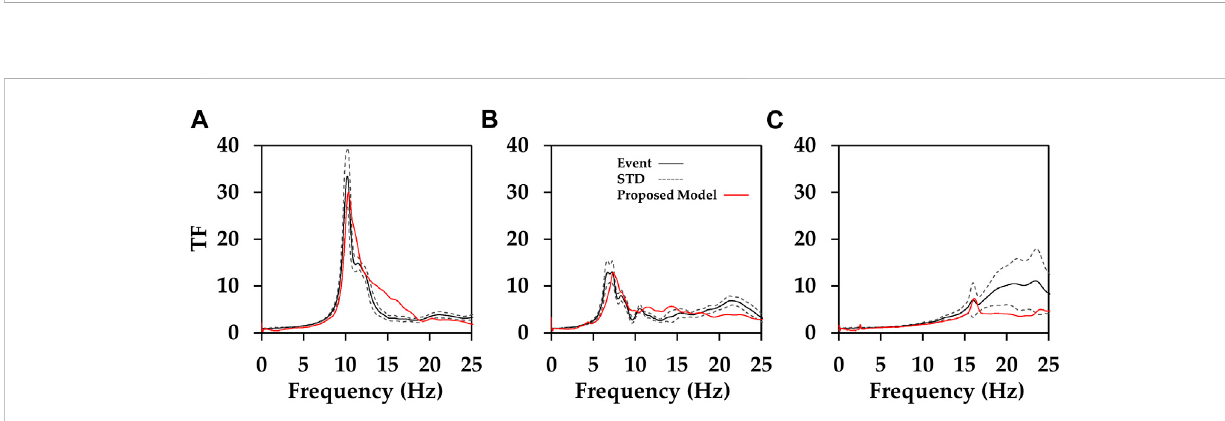
shown in Supplementary Figure S2. The transfer function was calculated based on the proposed method, as shown in Supplementary Figure S3.